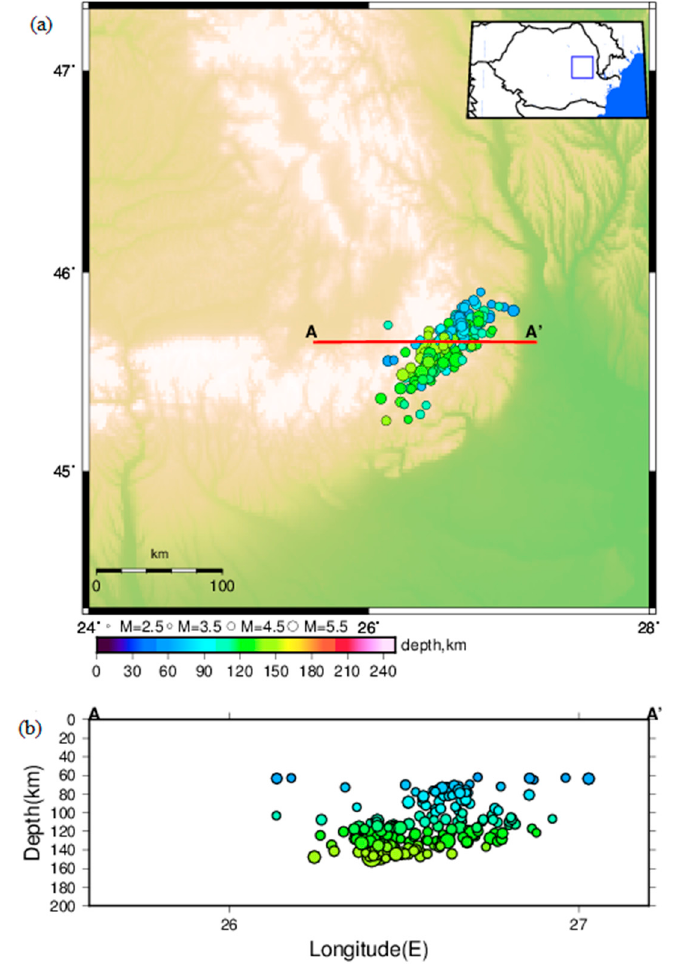
Figure 4. ( a ). Distribution of epicenters (size function of magnitude and color, according to depth) associated with subcrustal earthquakes (ML ≥ 2.5) produced during the period 1 April 2018–30 April 2019. The vertical profile A–A’ is shown in red. The inset shows the location of the study region on the map of Romania. ( b ) Vertical cross-sections along the A–A’ profile and hypocenters distribution within a distance of ±1.0 deg. relative to the same profile.